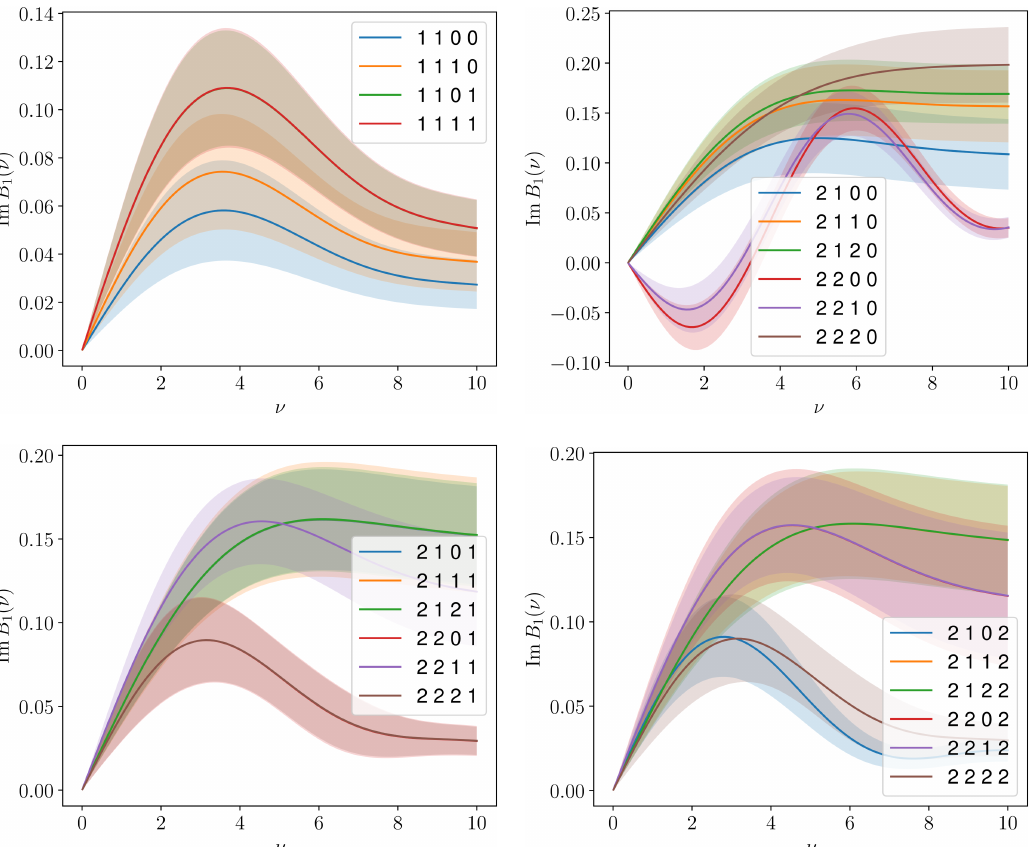
Figure 22 . The higher twist term, B 1 , results from fitting the imaginary component to the models. The numbers in the legend correspond to ( N ± , N